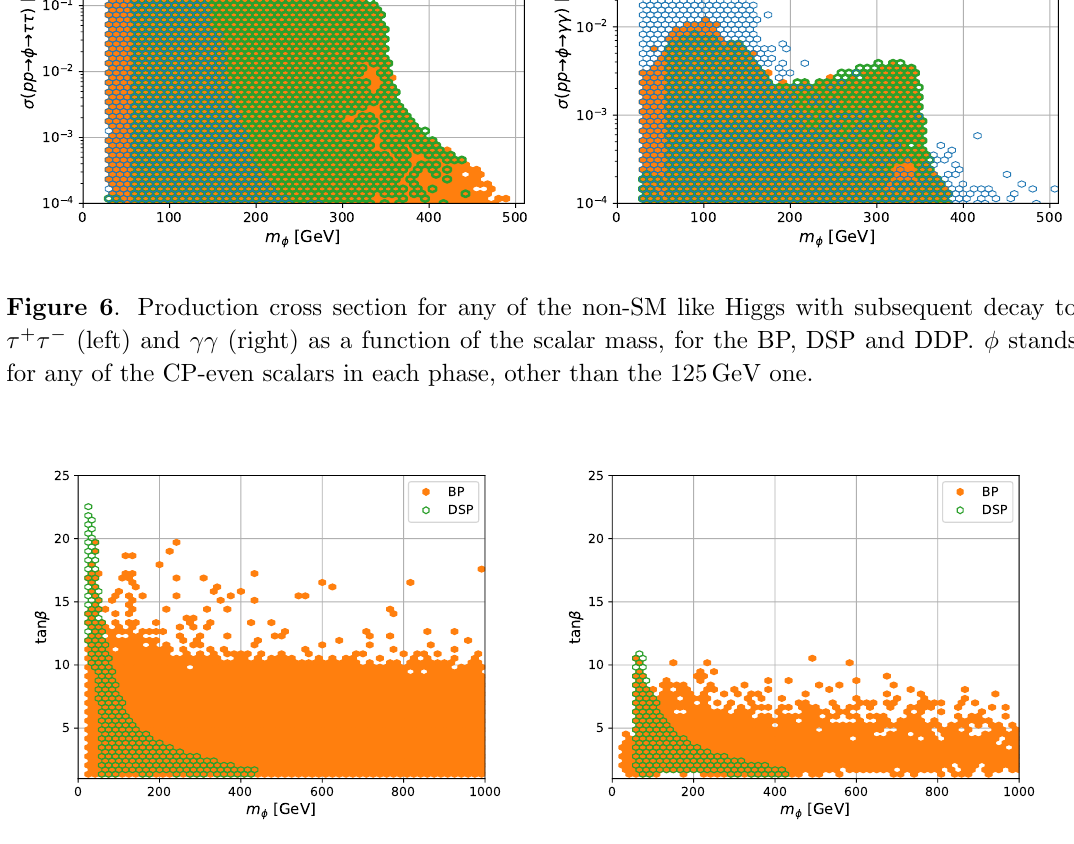
Figure 7 . tan (cid:12) as a function of the mass of any of the neutral non-SM like Higgs bosons with the present constraints (left) and taking the value of c ( h 125 V V ) to be 1 within 10 (cid:0) 3 (right), for the BP and DSP. Again, (cid:30) stands for any of the CP-even scalars in each phase, other than the 125 GeV